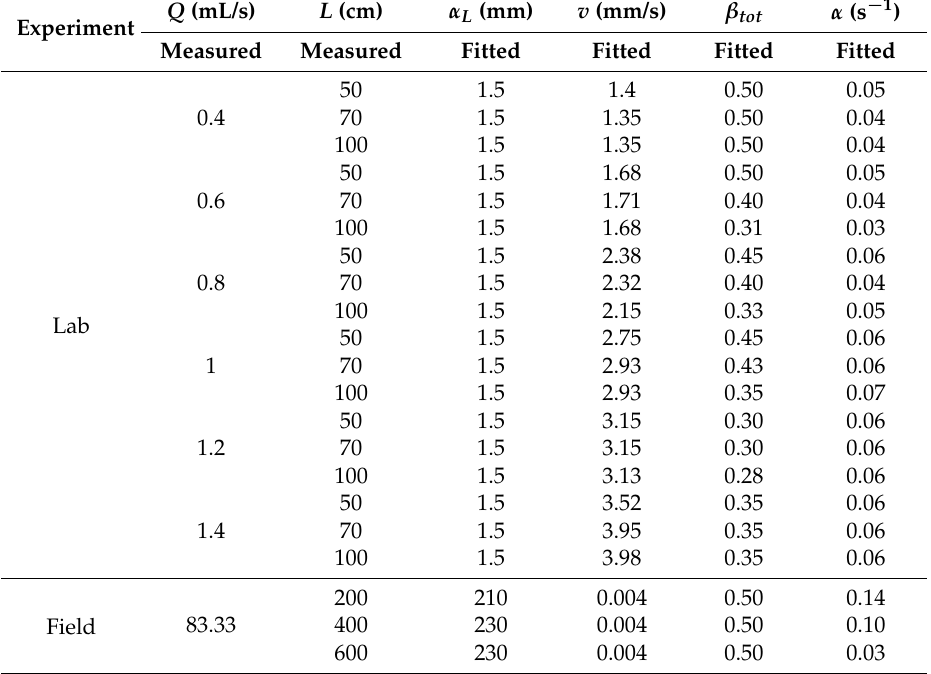
Table 2. The fitted parameters for the single mass-transfer rate mobile-immobile model (i.e., Equations (31)–(34)) at different flow rates and travel distances. In the legend, L denotes the travel distance (i.e., the length of the column); α L is the dispersivity; v is the flow velocity; β tot is the total capacity coefficient; and α stands for the mass transfer